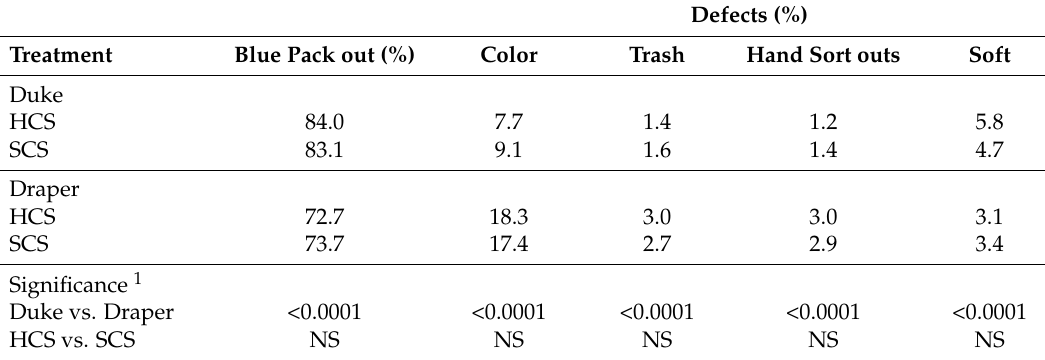
Table 1. Pack out of ‘Duke’ and ‘Draper’ blueberries after machine harvesting with hand-held pneumatic shakers used by workers standing on a platform built into a modified over-the-row harvester prototype with experimental hard and soft catch surfaces (HCS and SCS, respectively) in Oregon in 2017